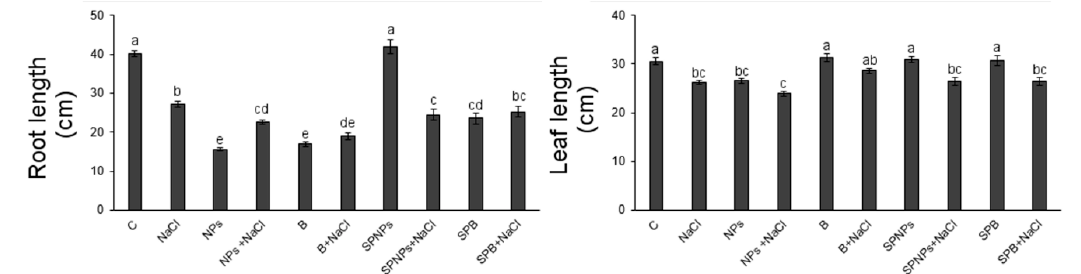
Figure 4. Length of roots and leaves of T. turgidum L. ssp. durum cv. Cappelli without priming and salt treatment (C), with salt treatment without priming (NaCl), with ZnO treatment in the root zone (nanoparticles, NPs or bulk form, B), with ZnO priming in the root zone with salt treatment (NPs + NaCl or B + NaCl), with ZnO treatment as a leaf spray (SPNPs or SPB), and with ZnO priming as a leaf spray with salt treatment (SPNPs + NaCl or SPB + NaCl): values are means of at least three replicates ± SE. When ANOVA highlighted significant differences, Tukey’s post hoc test was performed, and different letters indicate significantly different mean values at p < 0.05.